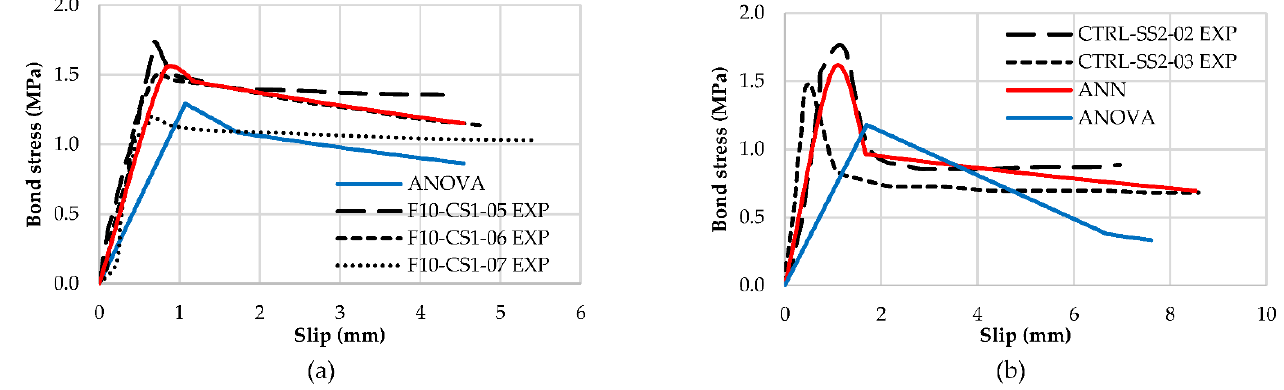
Figure 8. Experimental versus predicted interfacial behavior using ANN and ANOVA analysis of ( a ) circular and ( b ) squared specimens.